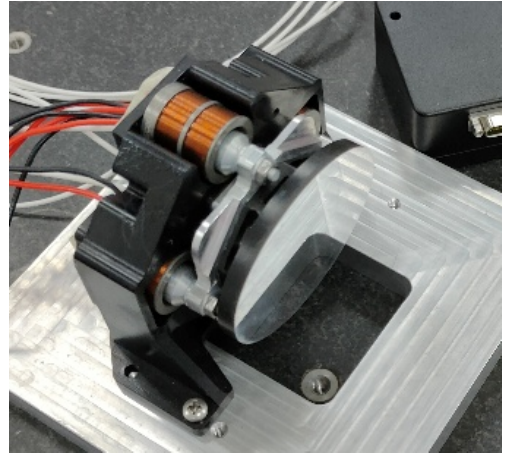
Figure 15. Outline of FSM.